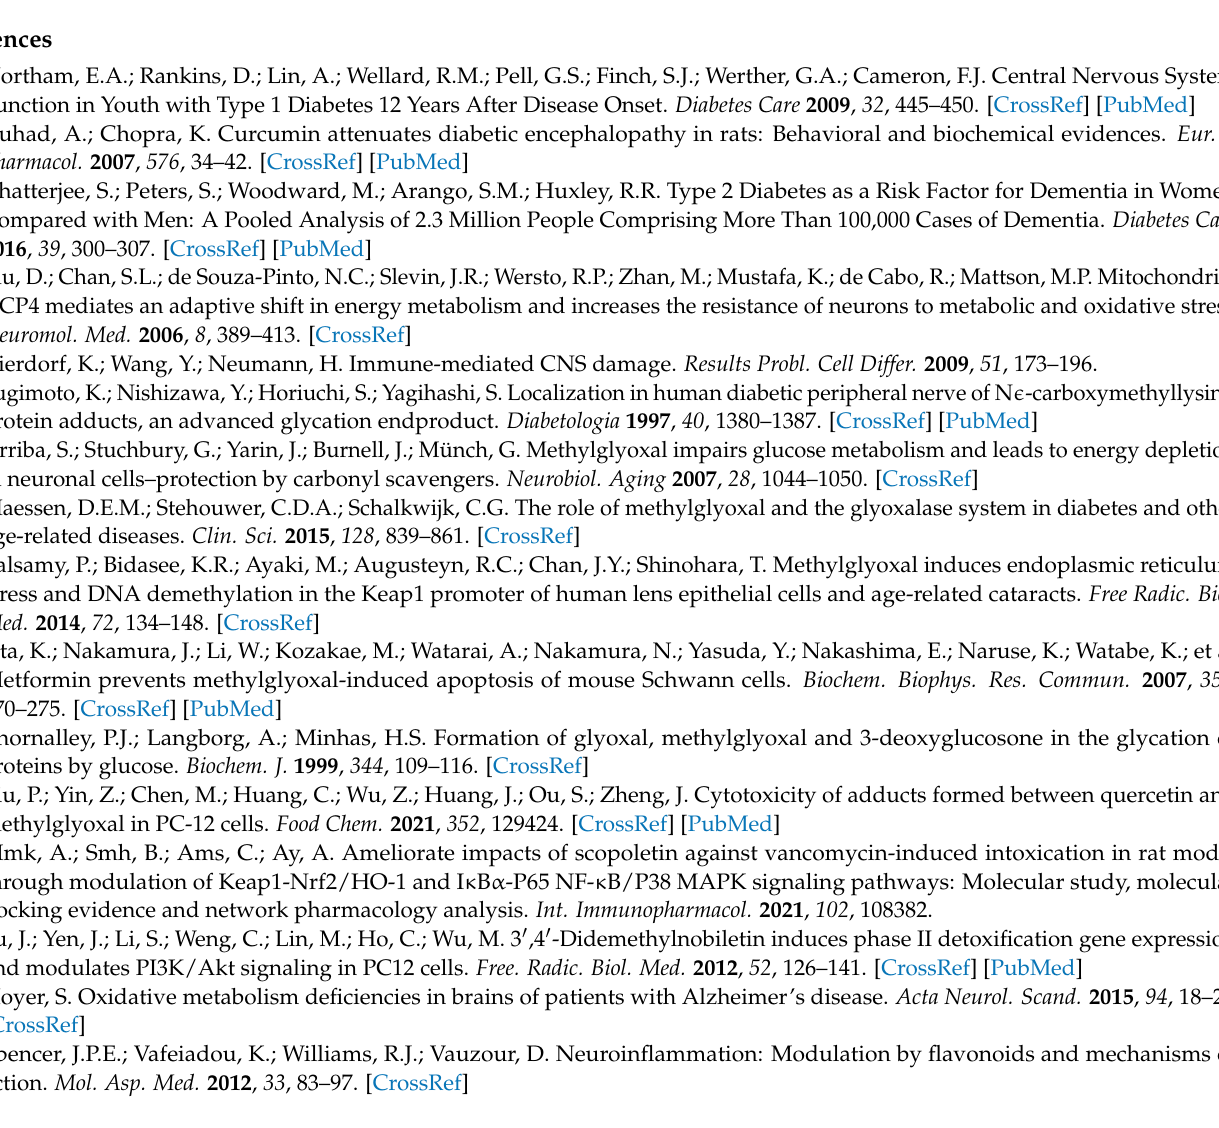
Figure S3: Other flavonoids tested in protective activities on MG-induced PC12 cells; Figure S4: The linear correlation between binding energy of main flavan 3-ols (EC, EGC, ECG, EGCG) and the EC 50 for MG-induced PC-12